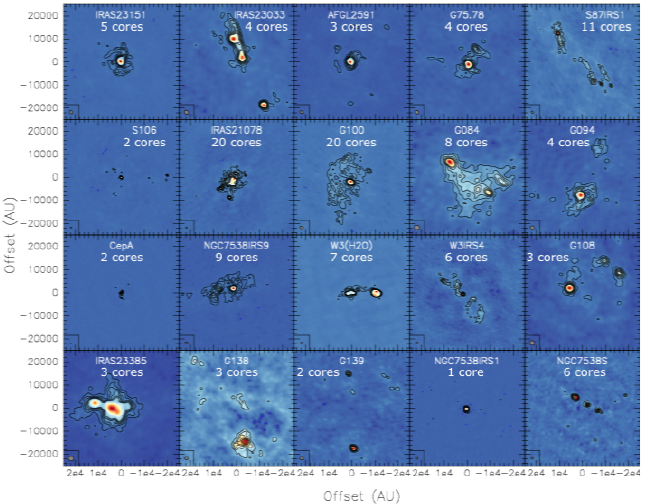
Table 1. NOEMA and NIKA2 specifications for a single pointing. Numbers below do not take into account fast mapping capabilities of NIKA2. NOEMA beam sizes are indicated for the three array configurations currently available (extended: A, intermediate: C, compact: D). σ is the point source continuum sensitivity obtained after one hour on source. More details are given in Sect. 2.